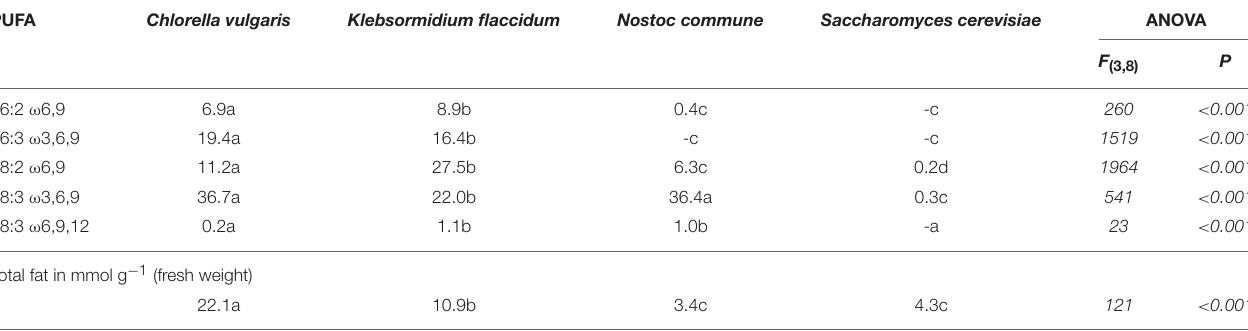
TABLE 2 | Proportion of polyunsaturated fatty acids (PUFA in % of total fatty acids) in the neutral lipids of photoautrotrophic microbiota dominant in terrestrial soil crusts. PUFA Chlorella vulgaris Klebsormidium flaccidum Nostoc commune Saccharomyces cerevisiae